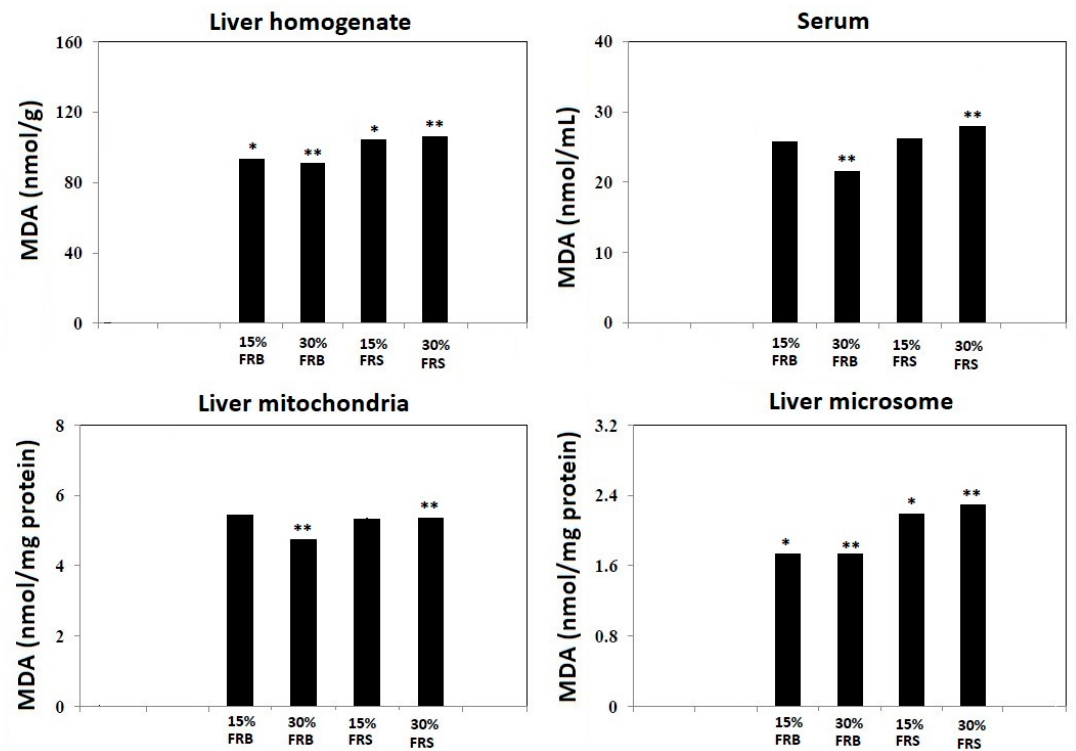
Figure 3. Effects of fermented rice bran (FRB) and fermented rice germ and soybean (FRS) on thiobarbituric acid reactive substances (TBARS) in the liver and serum. * Statistical significance at p < 0.05. ** Statistical significance at p < 0.05.